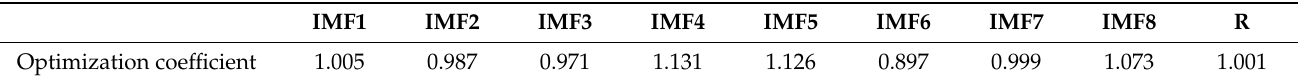
Table 2. Optimization coefficient